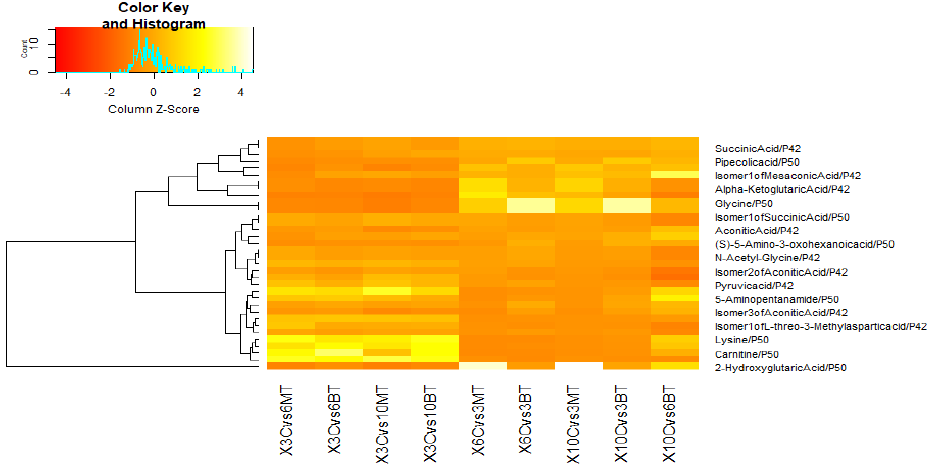
Figure 5. Heat map showing some of the differentially expressed metabolites of Cysteine and Methionine metabolism (P26) and Glycine, Serine, and Threonine metabolism (P40) pathways in different comparisons between positive control plants (C) and Metarhizium (MT) or Beauveria (BT) treatments at different Dpi. Z score is a measure of distance, in standard deviations, from the plate mean. A well with a Z score of 0 has the same raw value as the plate mean. A well with a Z score of 1.0 is exactly one standard deviation above the plate mean and a Z score of −0.5 is half a standard deviation below the plate mean.